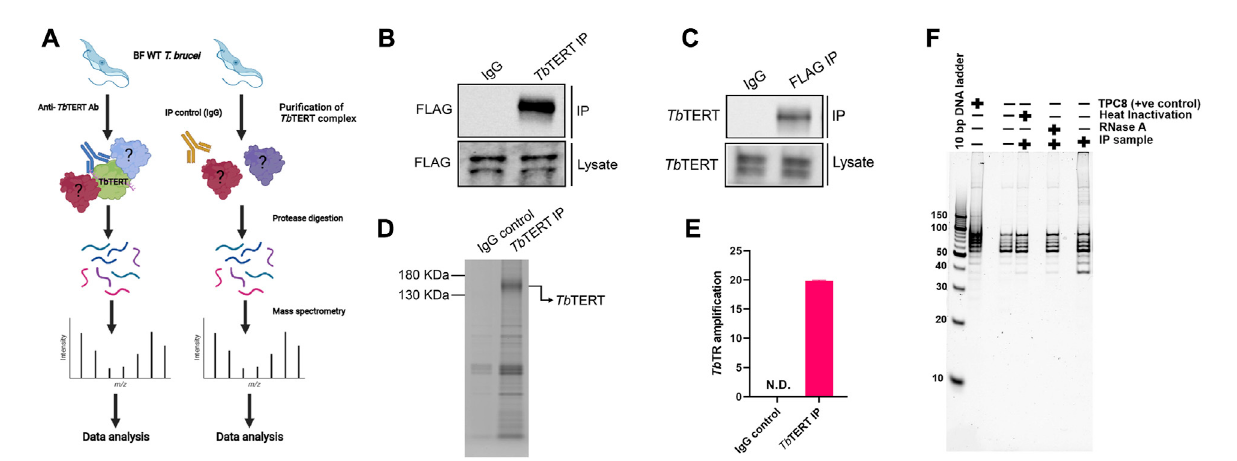
FIGURE 1 Af fi nity-puri fi cation mass spectrometry of bloodstream form T. brucei telomerase reverse transcriptase. (A) Experimental work fl ow for proteomic analysis. BF T. brucei cells expressing aFLAG tagged version of Tb TERT were grown and Tb TERT complexes werepuri fi edusing a custom anti- Tb TERT C terminus antibody.An IgGisotypeantibodywasusedas acontrol.Puri fi ed Tb TERT complexes werethendigested withtrypsin. Thesepeptides werethen analyzed byLC-MS/MS. (B) Westernblotcon fi rmingthepresence ofimmunopuri fi ed Tb TERT.IP sampleswereobtained and runonSDS-PAGEgels and immunoblotted with anti-FLAG antibody to detect Tb TERT. (C) Western blot con fi rming the presence of Tb TERT. IP samples were obtained and run onSDS-PAGEgelsandimmunoblotted withananti- Tb TERTCterminusantibodytodetect Tb TERT. (D) SDS-PAGEanalysisofimmunopuri fi ed Tb TERT.A small aliquot was also resolved on SDS-PAGE and stained with Coomassie stain to qualitatively check Tb TERT protein levels. (E) RT-qPCR detection of Tb TR from Immunopuri fi ed Tb TERT complexes. (F) Telomerase activity of the bead-bound telomerase enzyme was analyzed by telomerase primer extension assay.